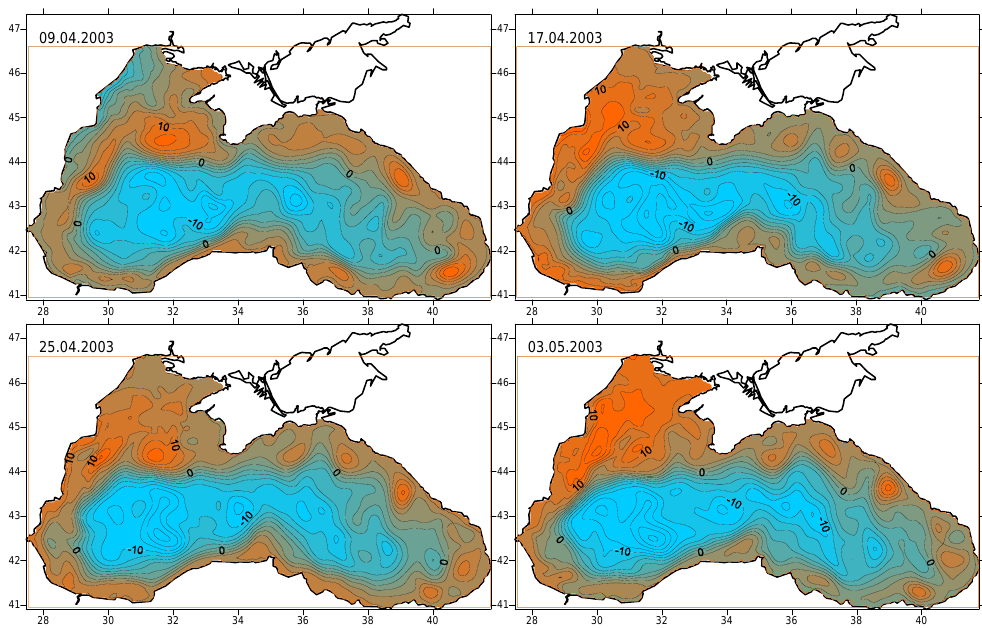
Figure 2 Short-term evolution of the sea surface topography. Fig. 2. Short-term evolution of the sea surface